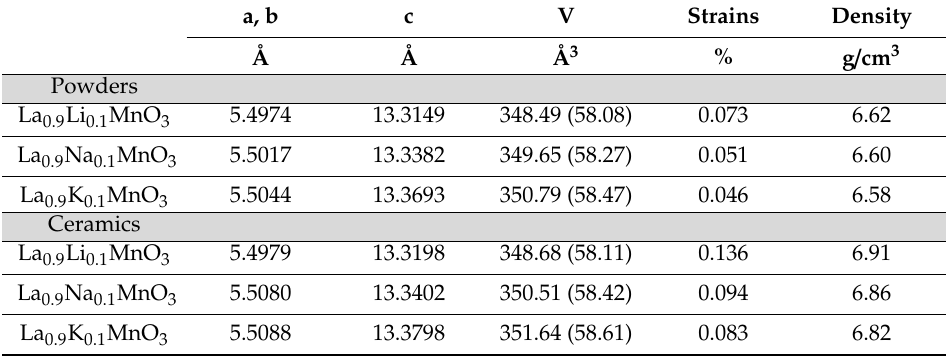
Table 1. Cell parameters obtained from XRD patterns for La 0.9 A 0.1 MnO 3 powders and ceramics. a, b c V Strains Density Å Å Å 3 % g / cm 3